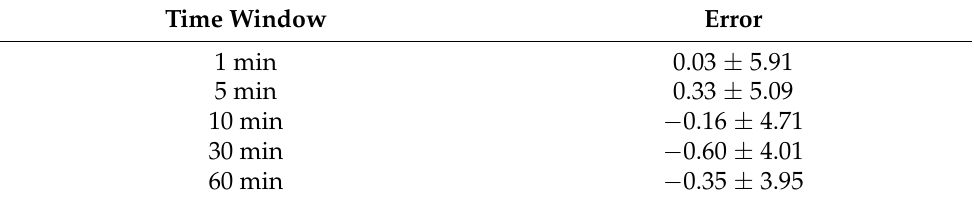
Table 1. HR estimation error. The estimation errors are expressed as mean ± standard